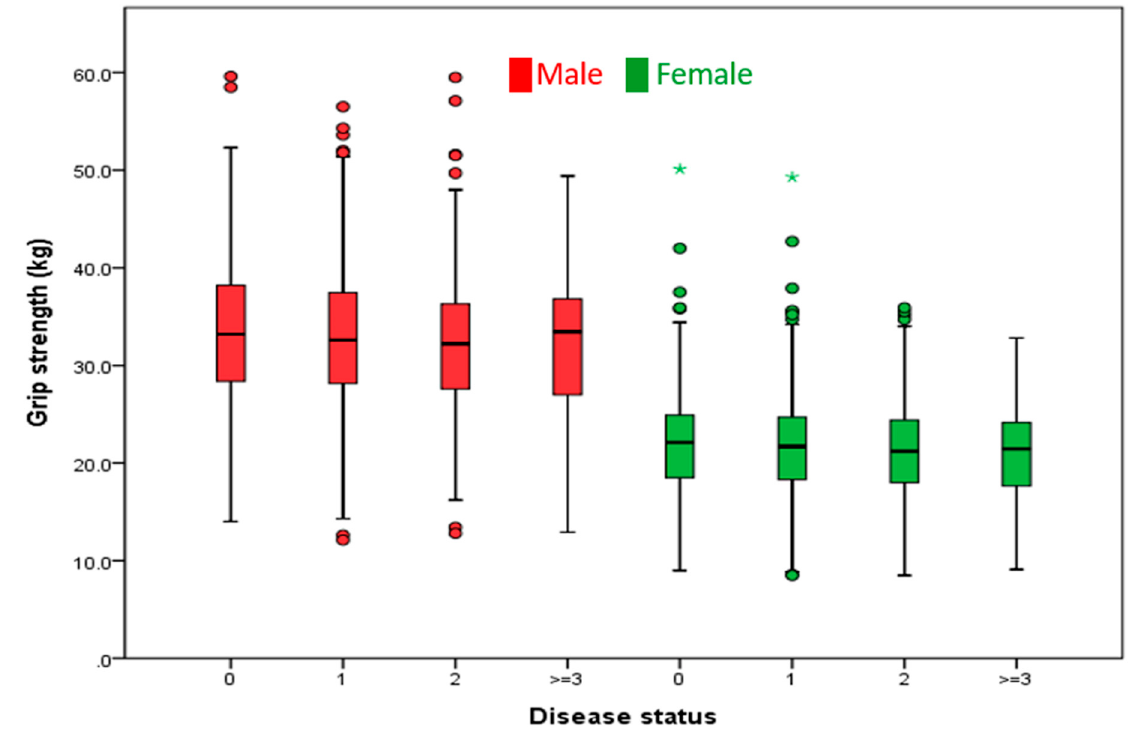
Figure 1. Box plots of grip strength among different disease statuses in the elderly.